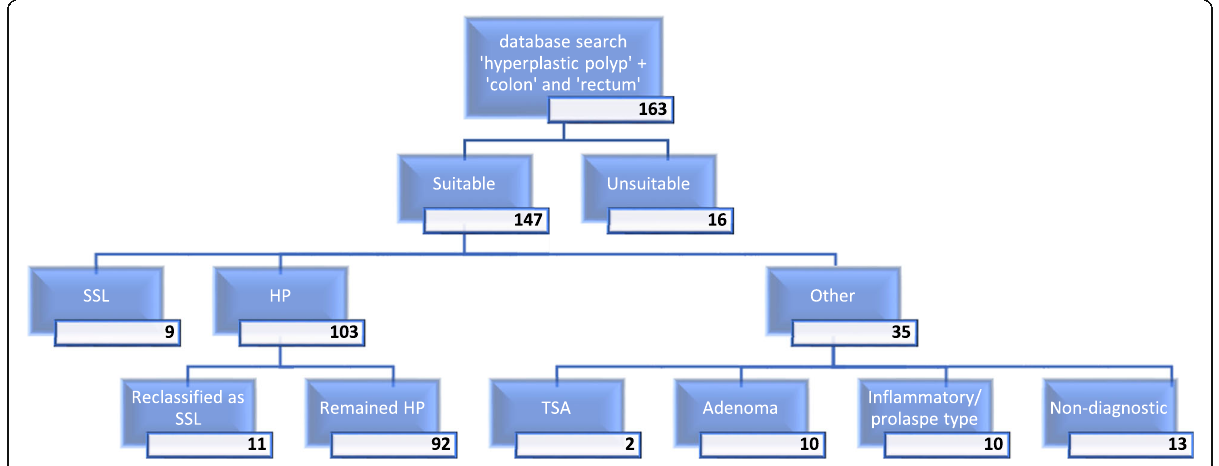
Fig. 3 Flow diagram showing outcome of histological review of initial 163 cases